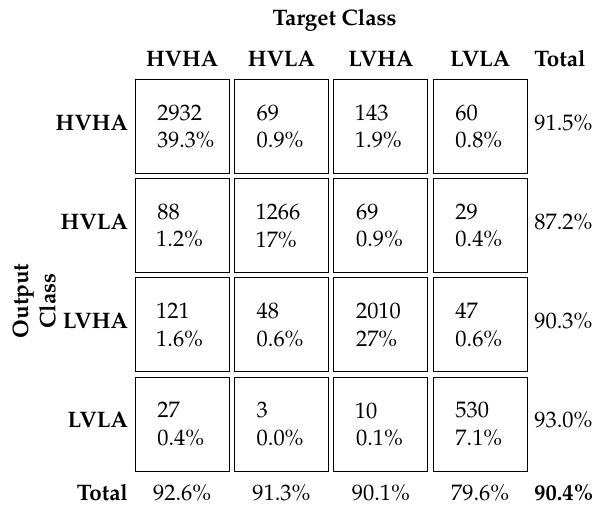
Table 7. Confusion matrix of ECG channel 1 of DREAMER dataset.